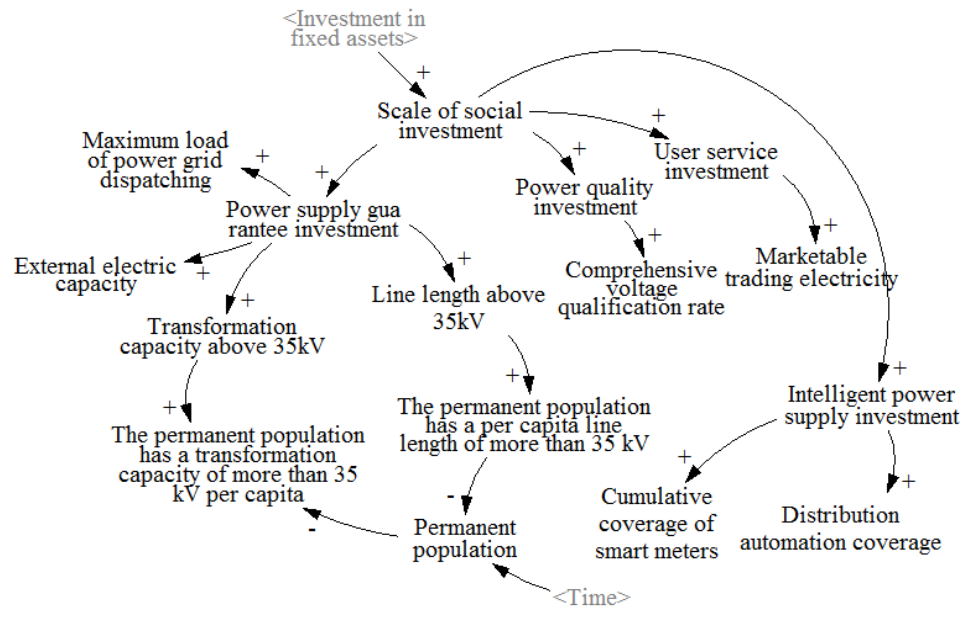
Figure 4. Cause and effect analysis diagram of social investment subsystem of grid company .